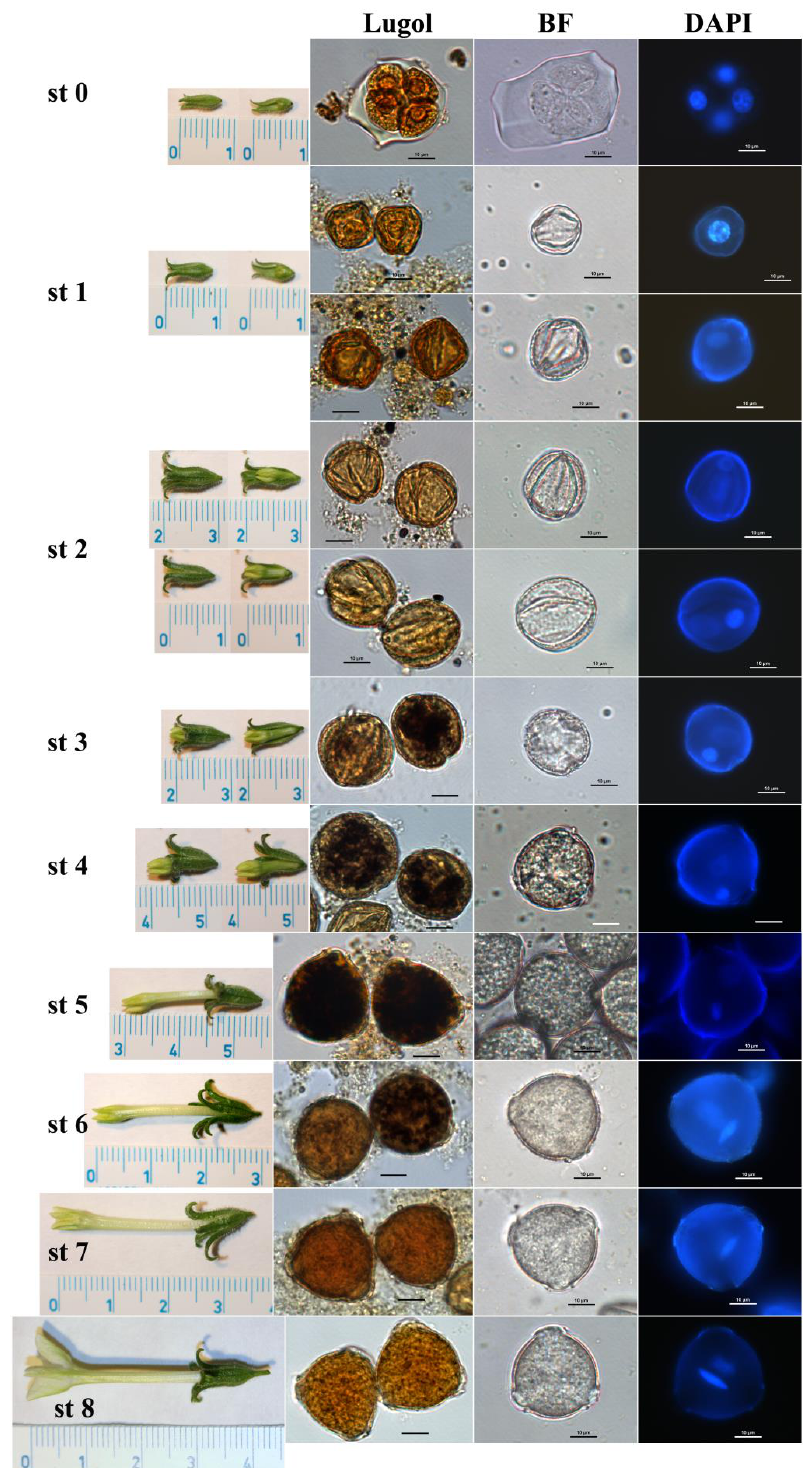
Figure 1. Images of Nicotiana benthamiana flower and pollen developmental stages (st 0 – 8), which were characterized according to length and morphology of flower buds, together with the cytological characteristics of pollen grains (number and shape of nuclei after DAPI staining, starch content after staining using Lugol solution). BF; pollen grains under bright field without any staining. Millimeter scale in flower bud images. Scale 10 µm in pollen microscopic images. A detailed word description of individual stages is given in Table S1.